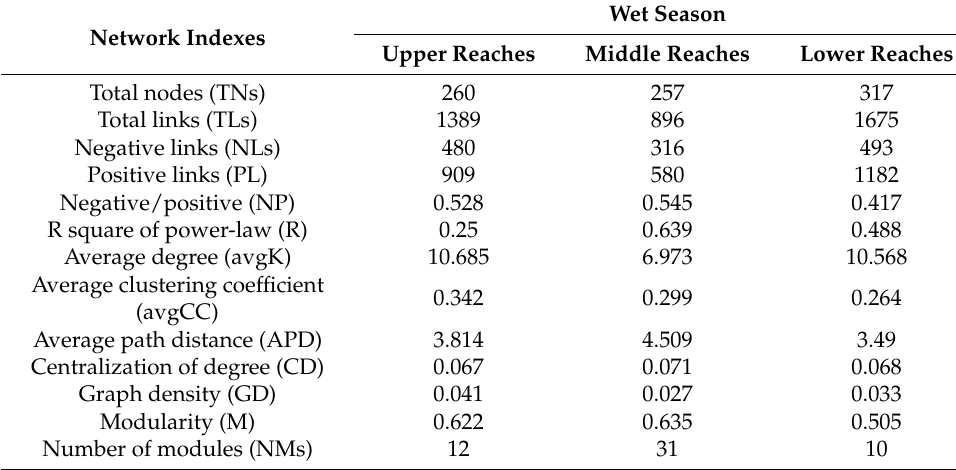
Table 1. The topological properties of the bacterioplankton molecular ecological networks during the wet season.